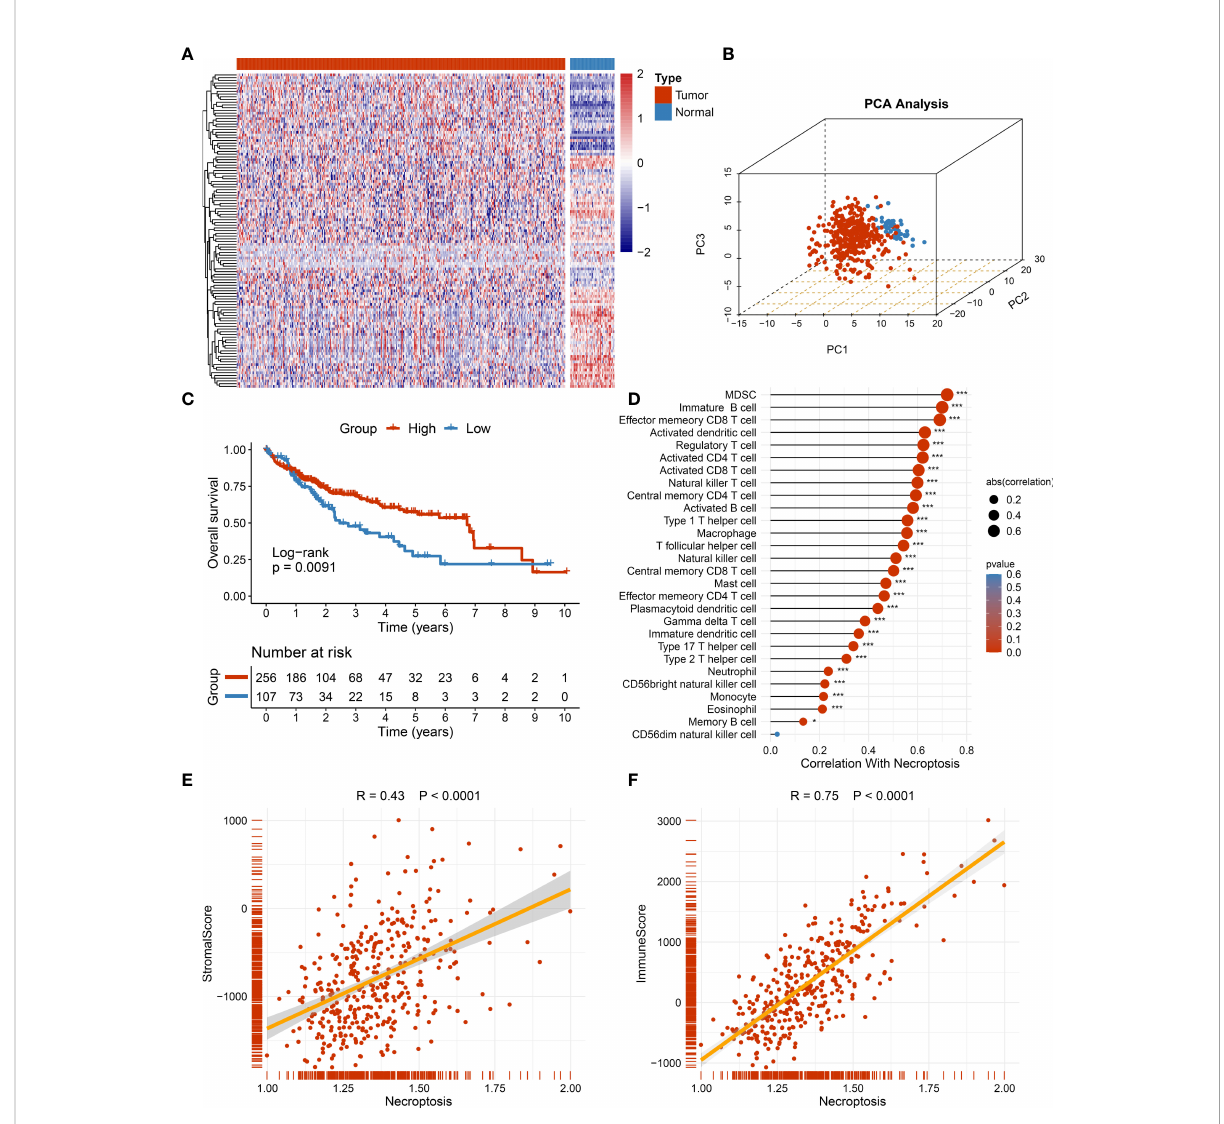
FIGURE 2 The role of necroptosis in tumor microenvironment (TME). (A) The expression of 115 necroptosis-associated genes between tumor and normal tissue. (B) The distribution of all samples using principal component analysis (PCA) in TCGA-LIHC dataset. (C) Kaplan – Meier curves of overall survival